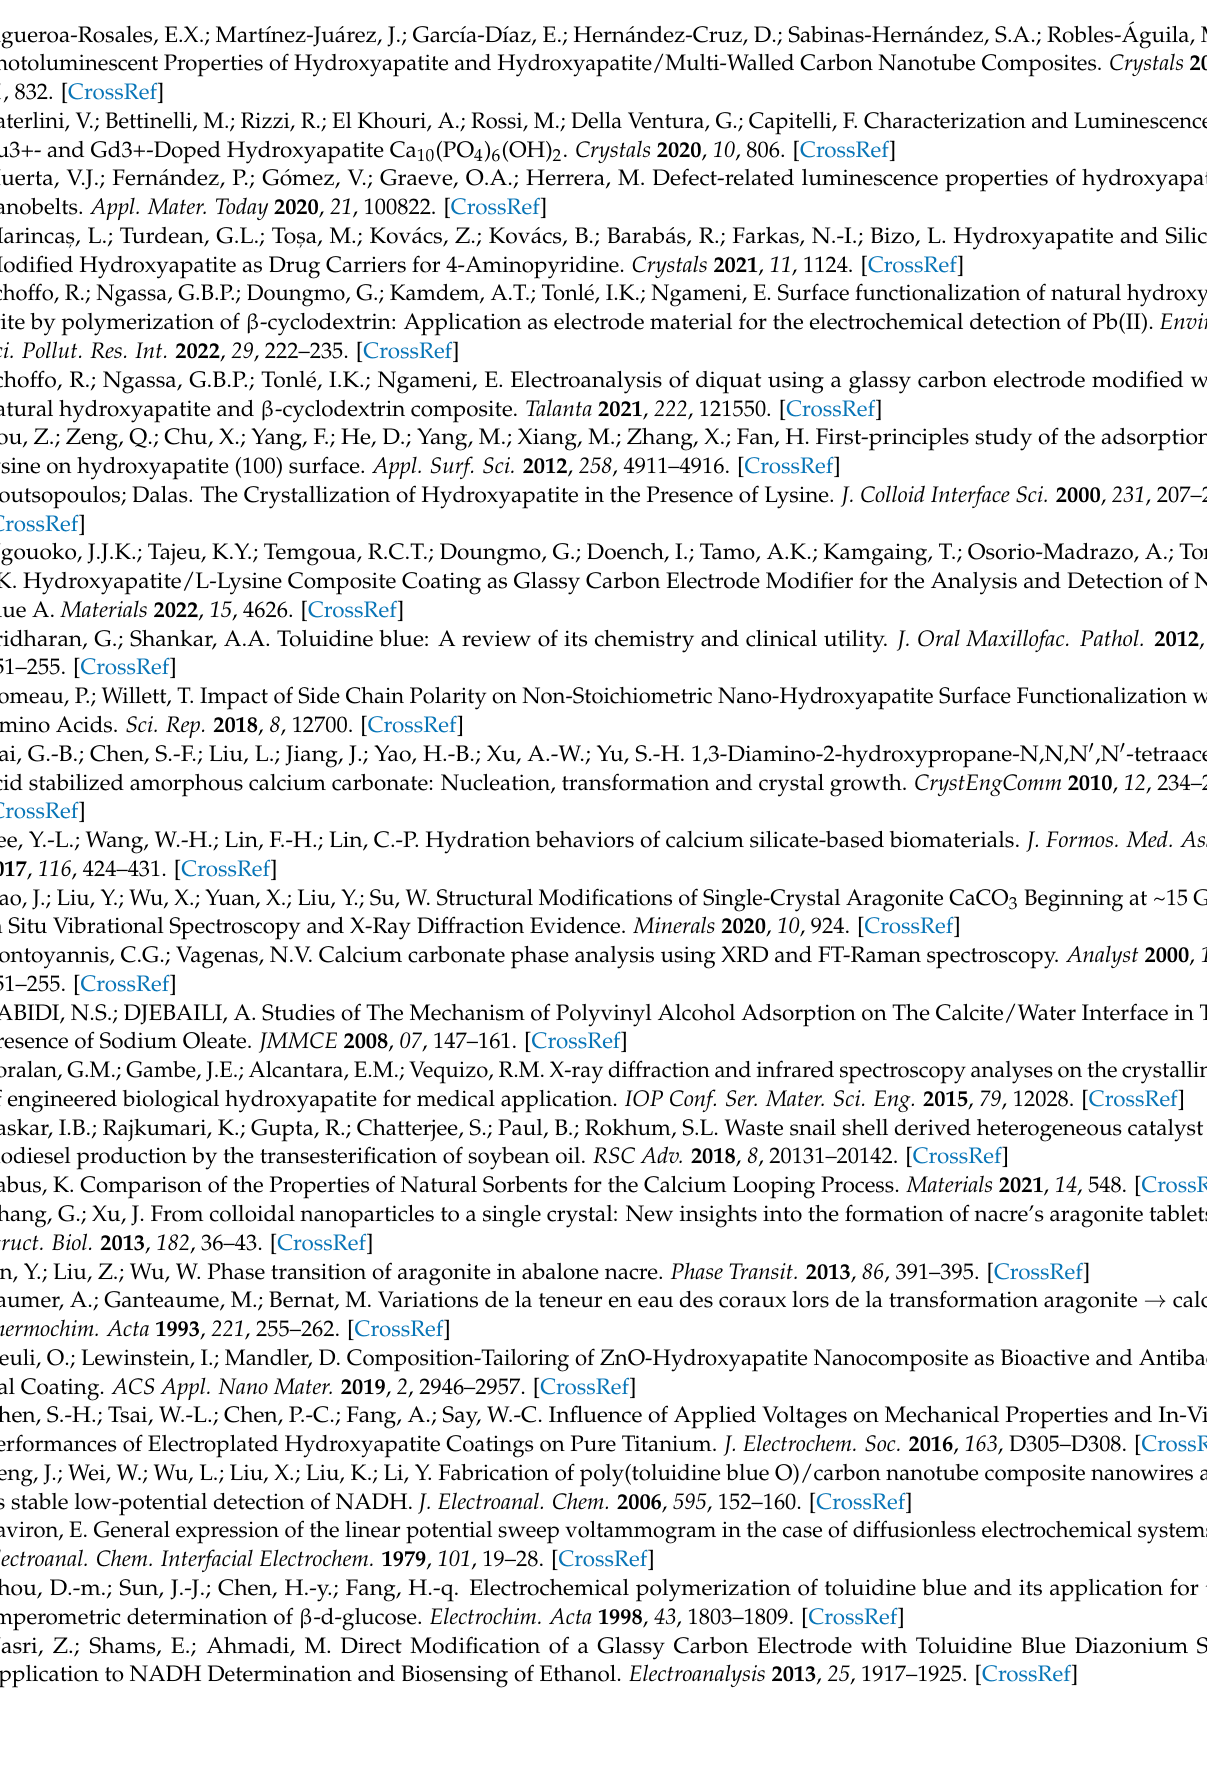
Figueroa-Rosales, E.X.; Mart í nez-Ju á rez, J.; Garc í a-D í az, E.; Hern á ndez-Cruz, D.; Sabinas-Hern á ndez, S.A.; Robles- Á guila,